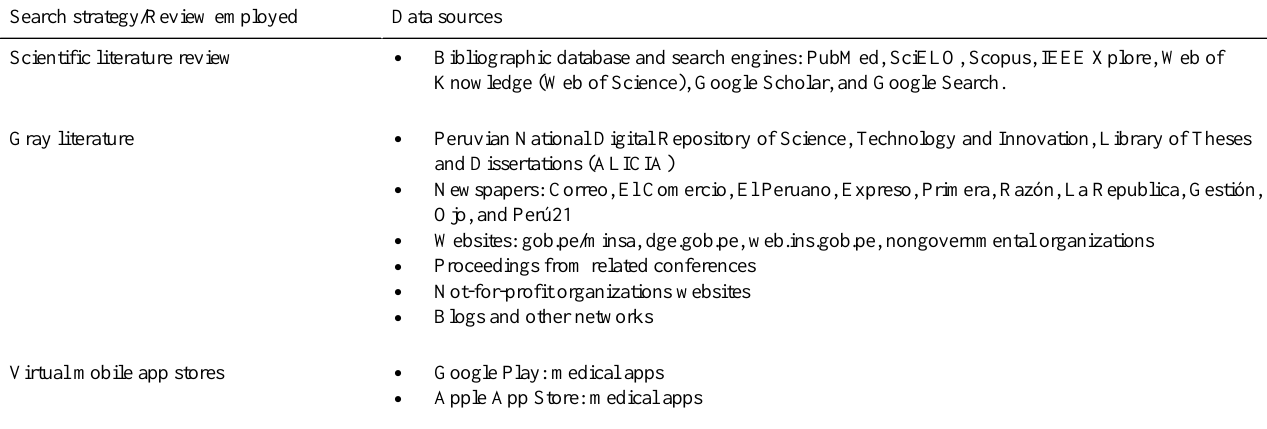
Table 1. Search strategy.